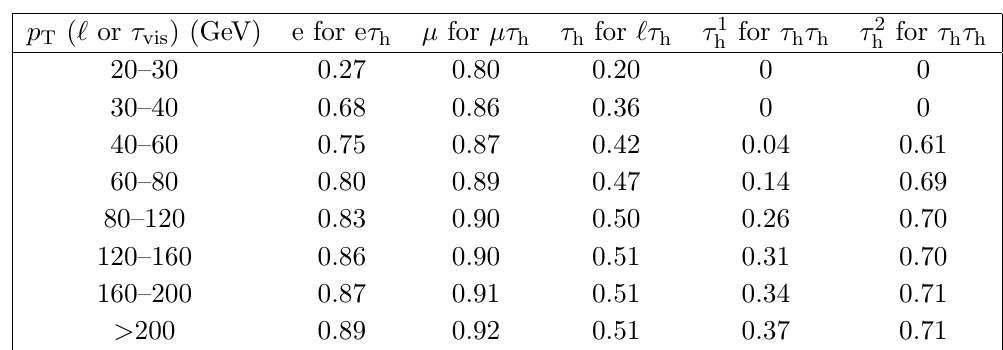
1 and (cid:28) 2 stand for leading h in di(cid:11)erent channels. Here, (cid:28) h h